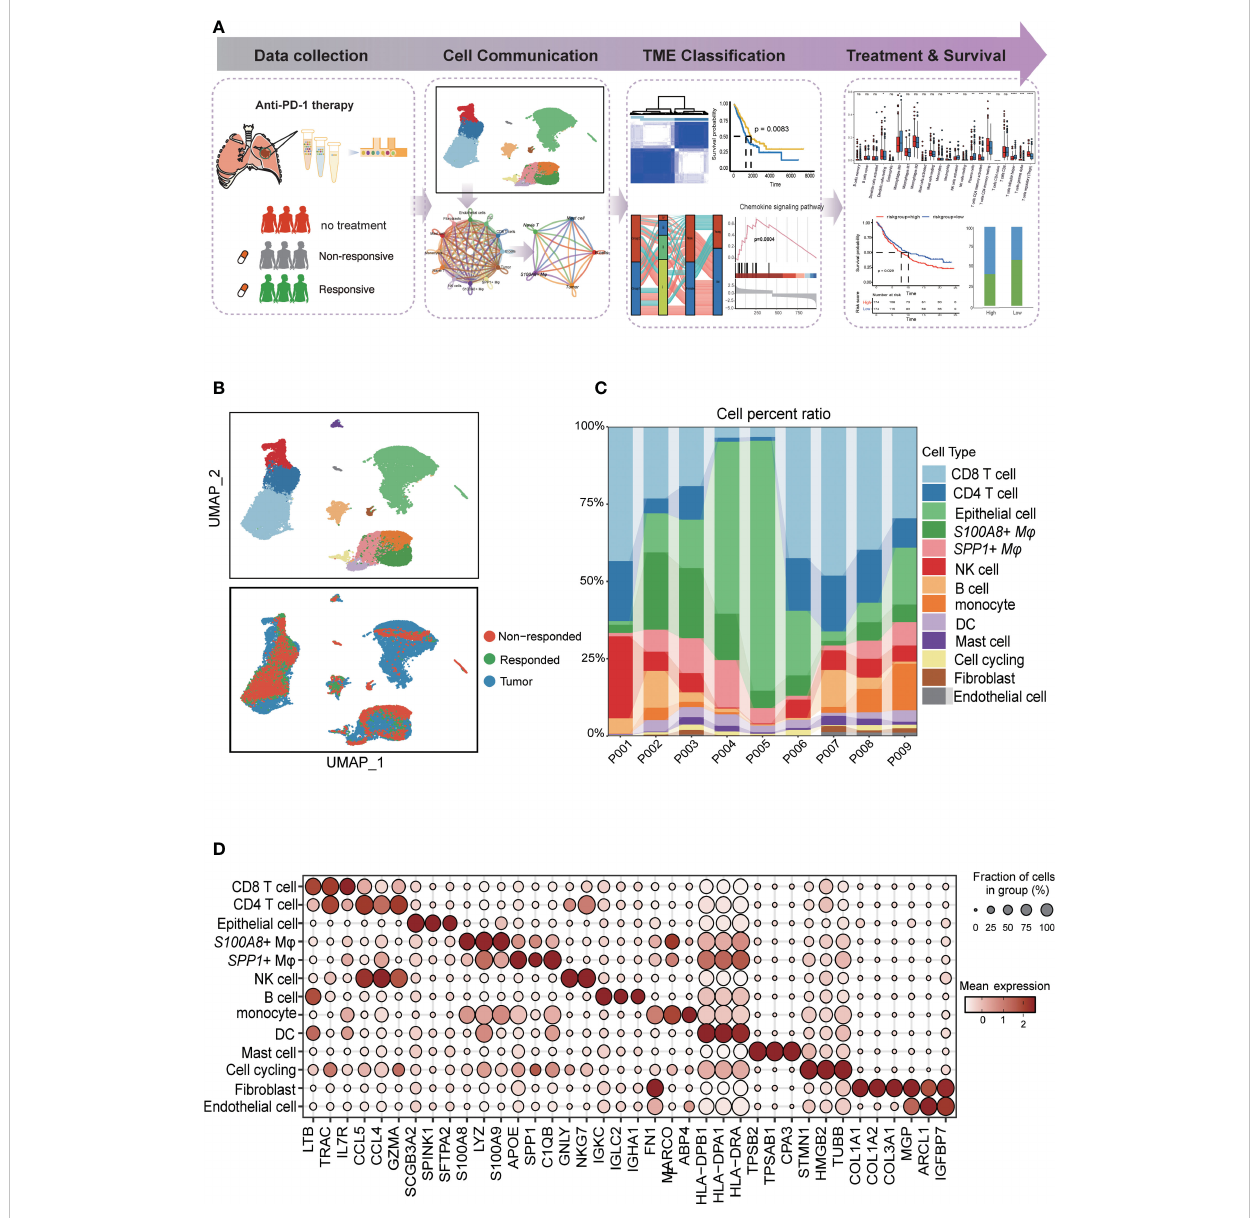
FIGURE 1 Diverse cell types in LUAD were delineated by single-cell RNA-seq analysis. (A) Schematic of tissue dissociation, cell isolation, sequencing, and downstream bioinformatics analysis. (B) UMAP plots of the major LUAD cell populations from untreated patients and responders and nonresponders after PD-L1 treatment. Each point depicts a single cell, colored according to cell type (top). The distribution of cells from three groups is divided by treatment or response (bottom). (C) Stacked bar plots showing the frequencies of 13 cell types in seven samples. The chart shows the number and percentage of each cell type. (D) Dot plots showing the single-cell expression pattern of cell-type-speci fi c top 3 gene markers in each cell